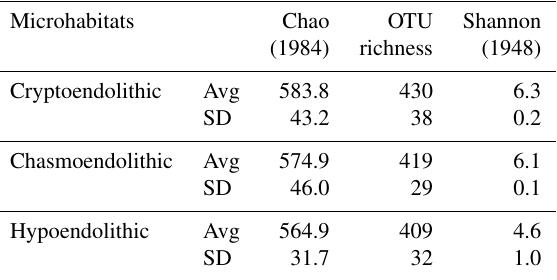
Table 1. Diversity estimates of microbial communities in the en- dolithic microhabitats of gypcrete.